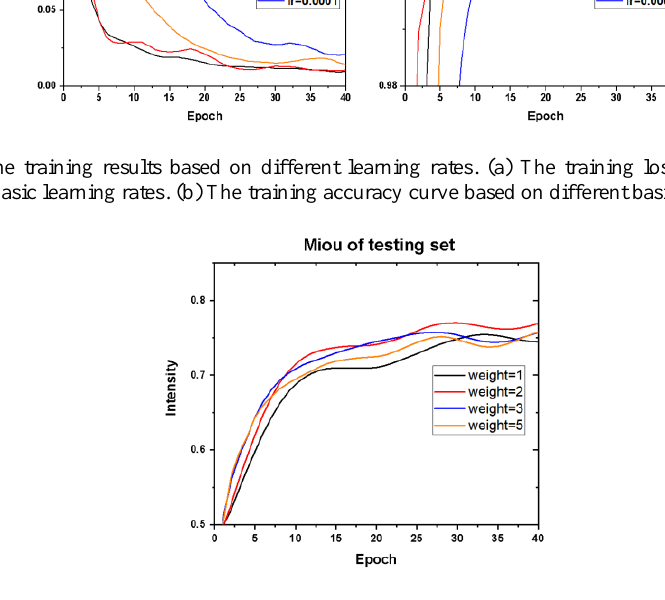
Fig. 2. The mean interaction over union (MIOU) of the testing set based on different object class weights of 1, 2, 3, and